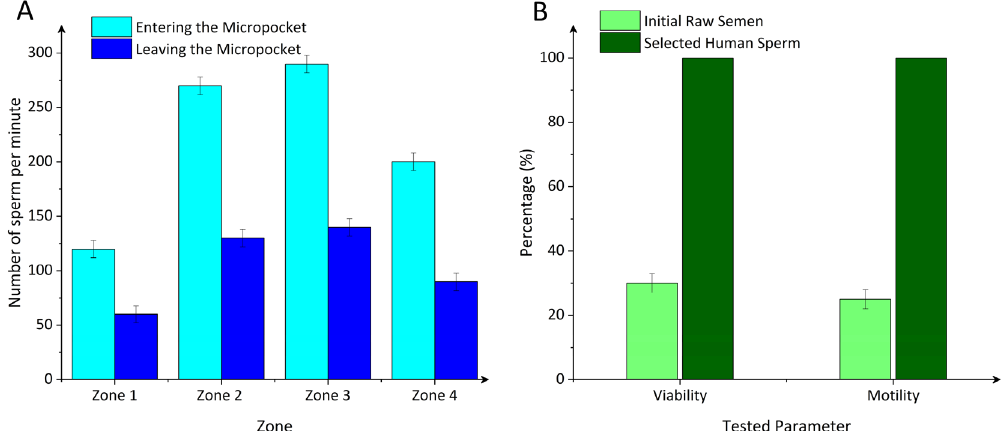
Figure 6. Selected sperm quality analysis at a flow rate of 2 µL/min. ( A ) Number of sperm entering and leaving the micropockets per minute as a function of selection zone. ( B ) Selected human sperm viability and motility as compared to the initial raw sample. Values are reported as mean ± s.d. (n ≥